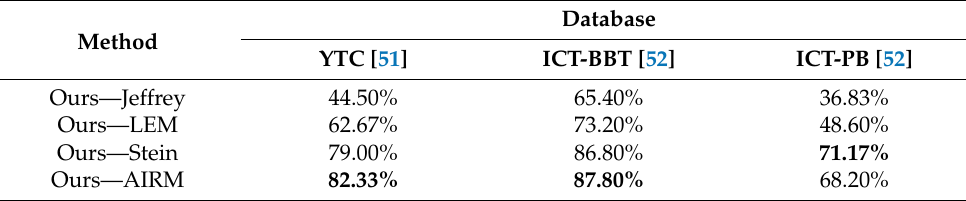
Table 1. Recognition result on our proposed method with different